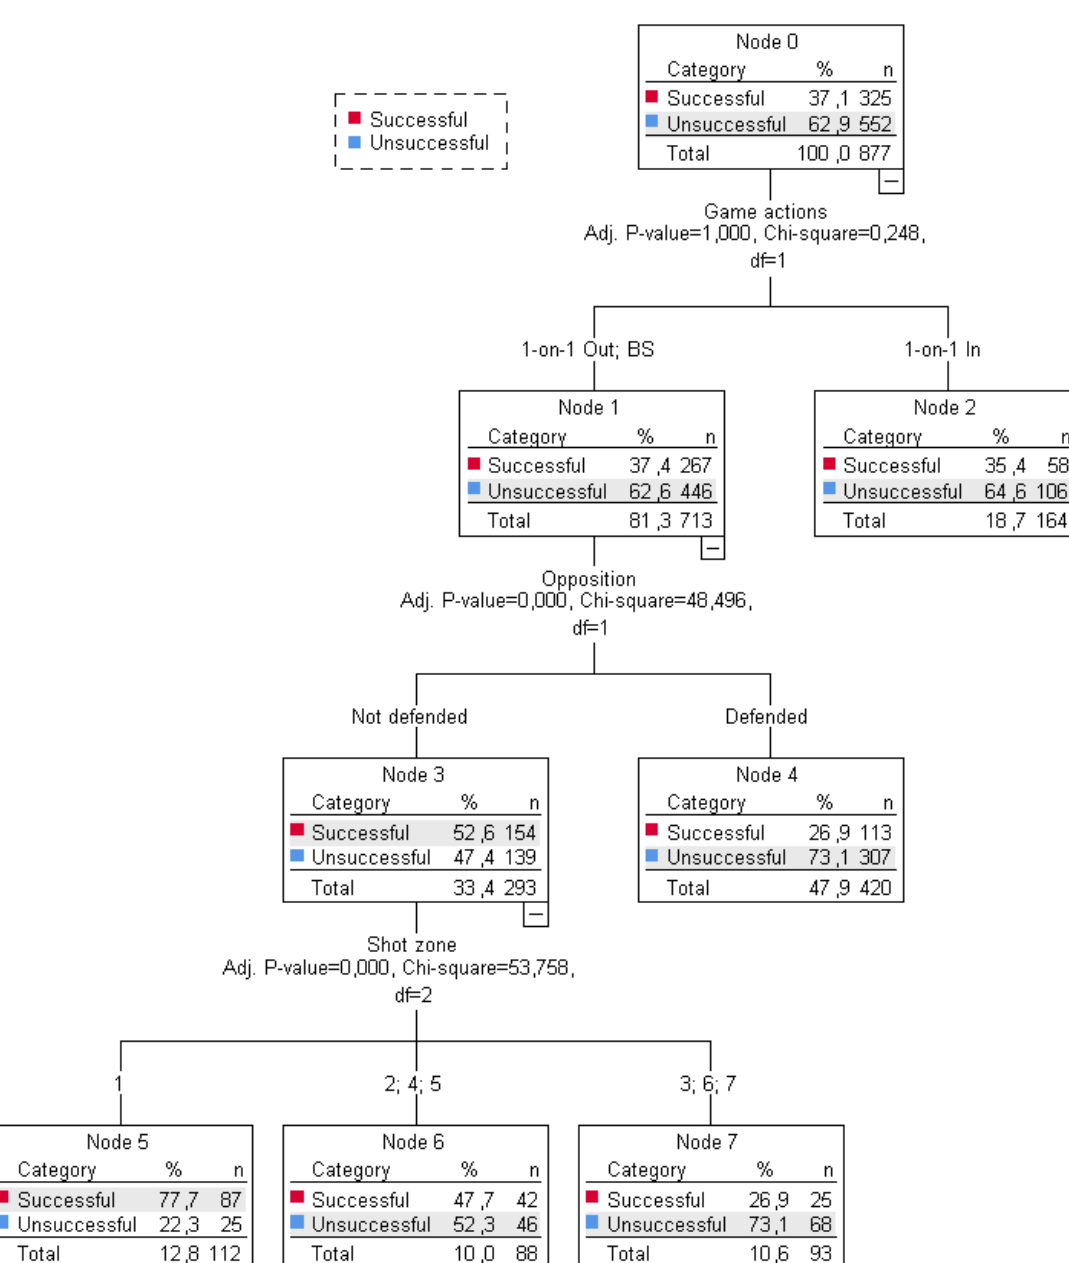
Figure 3. Game actions (1-on-1, Ball Screen) and shot zone as key variables in predicting shot success.